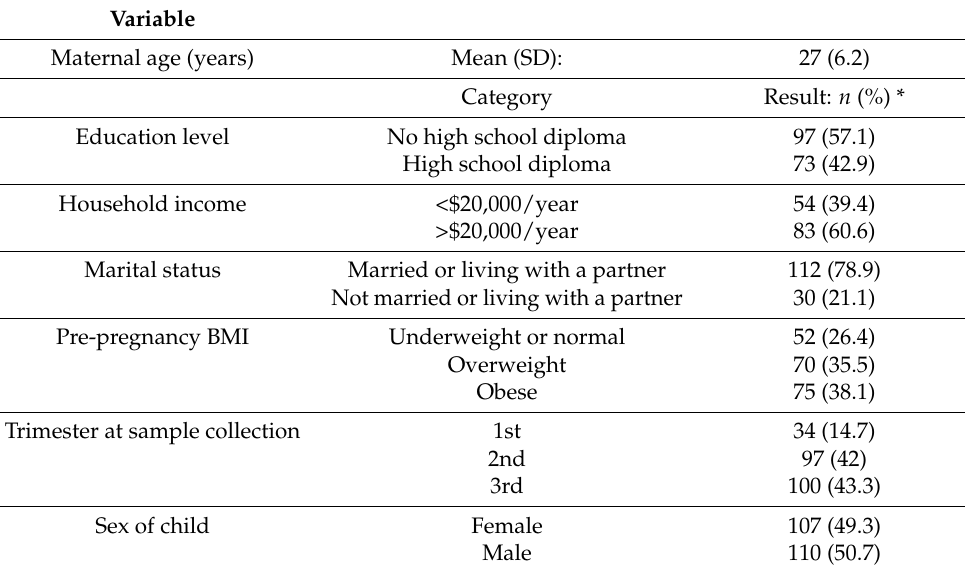
Table 1. Summary of sociodemographic characteristics of study cohort ( n =